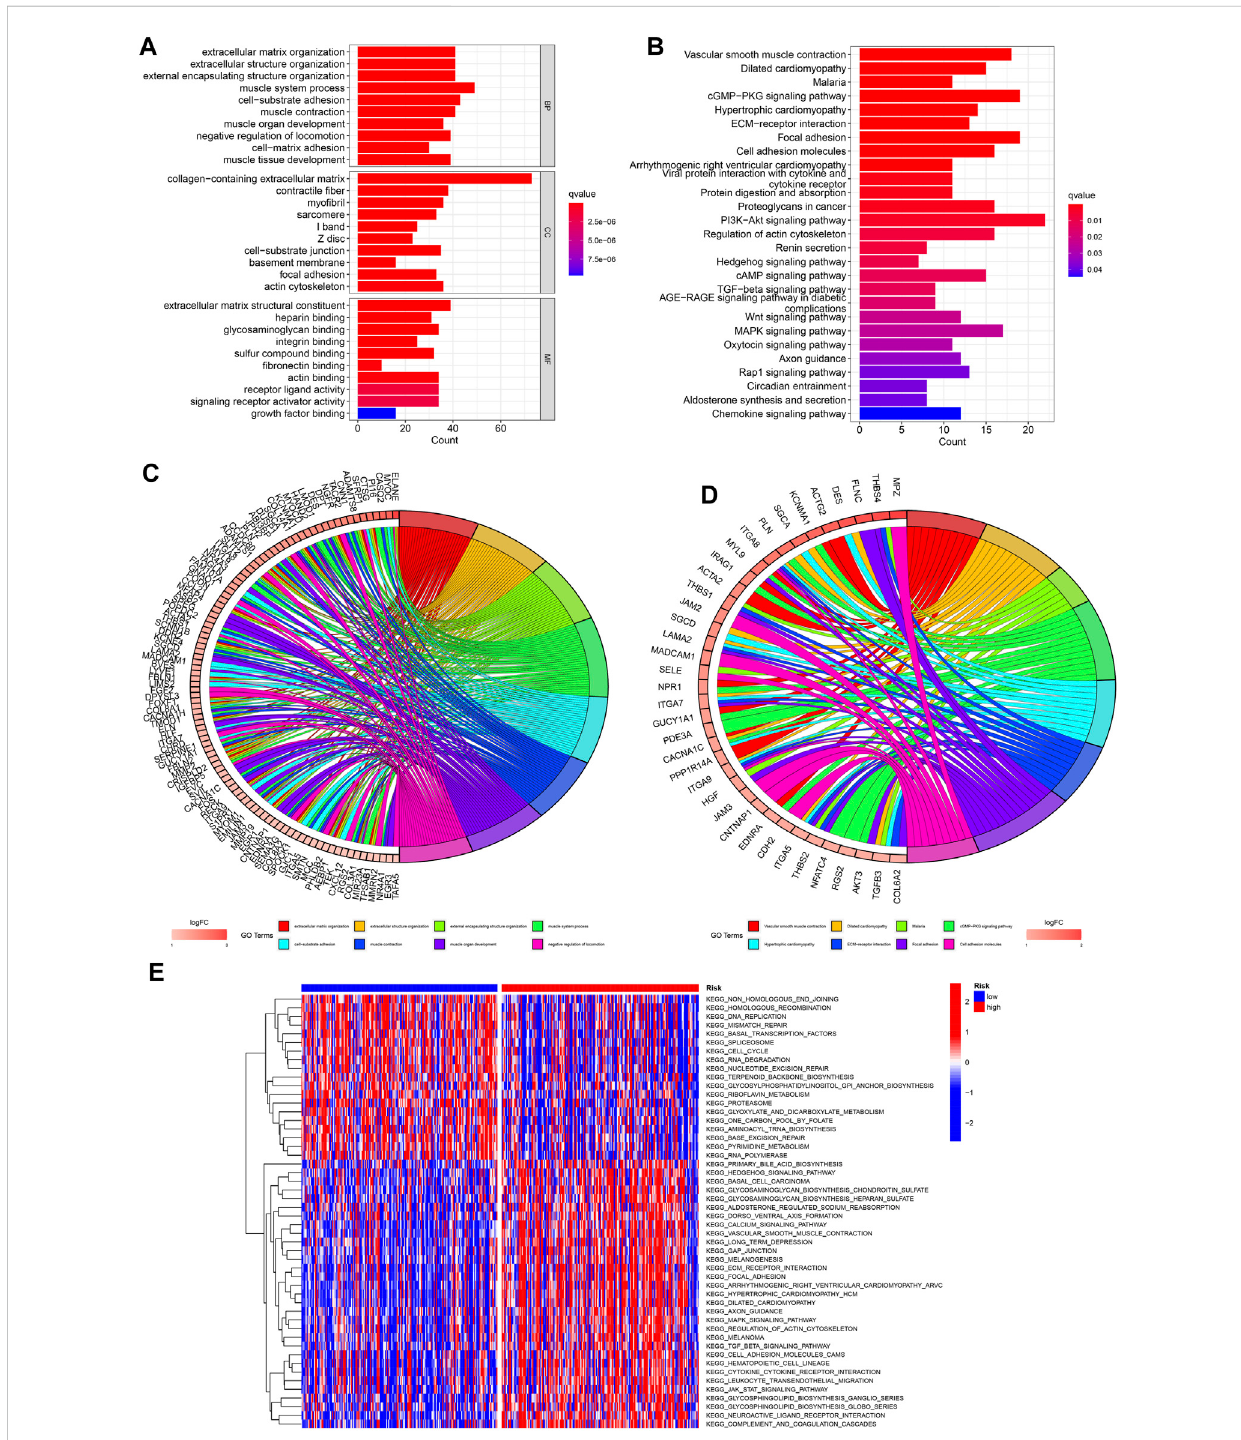
FIGURE 14 Functionalenrichmentanalysis. (A.C) GOanalysisofDEGsbetweenlow-andhigh-riskGC. (B,D) KEGGanalysis. (E) GSVAanalysisoflow-andhigh- risk